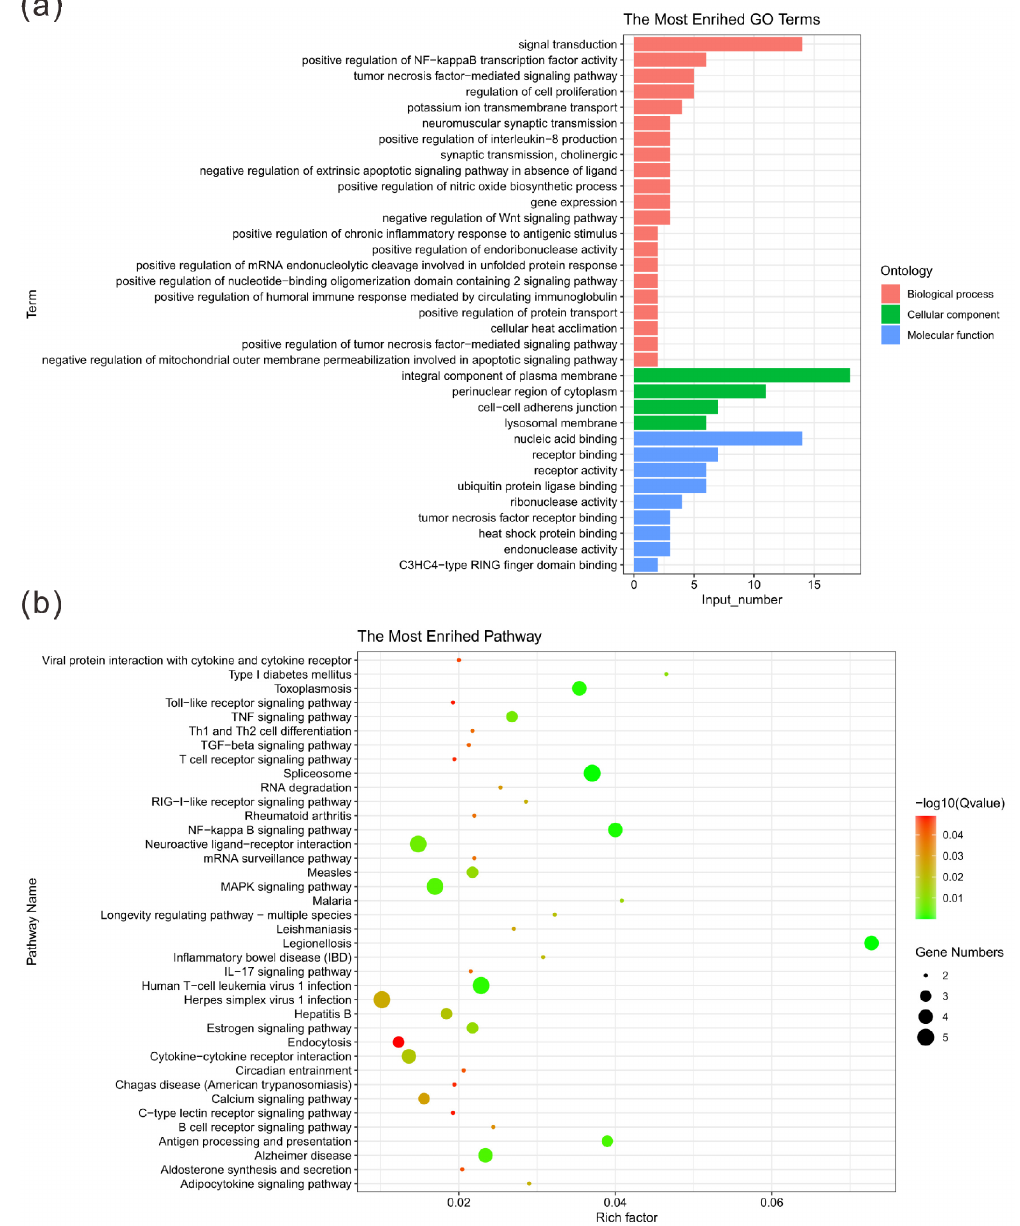
Figure 3. Statistics of GO terms and pathways. ( a ) Histogram of the top 30 GO terms. The ordinate shows the enriched GO term; the abscissa shows the number of genes in the term. Orange, green and blue indicate biological processes, cellular components and molecular functions, respectively. ( b ) Bubble diagram of the top 20 pathways. The pathway names are shown in the legend on the left. The abscissa is the enrichment factor, which represents the ratio of the proportion of genes annotated to a pathway in a differential gene to the proportion of genes in all genes annotated to that pathway. The larger the enrichment factor, the more significant the level of enrichment of the differentially expressed genes in this pathway. The size and color of the dots represent the number of enriched genes and the magnitude of significance, respectively.